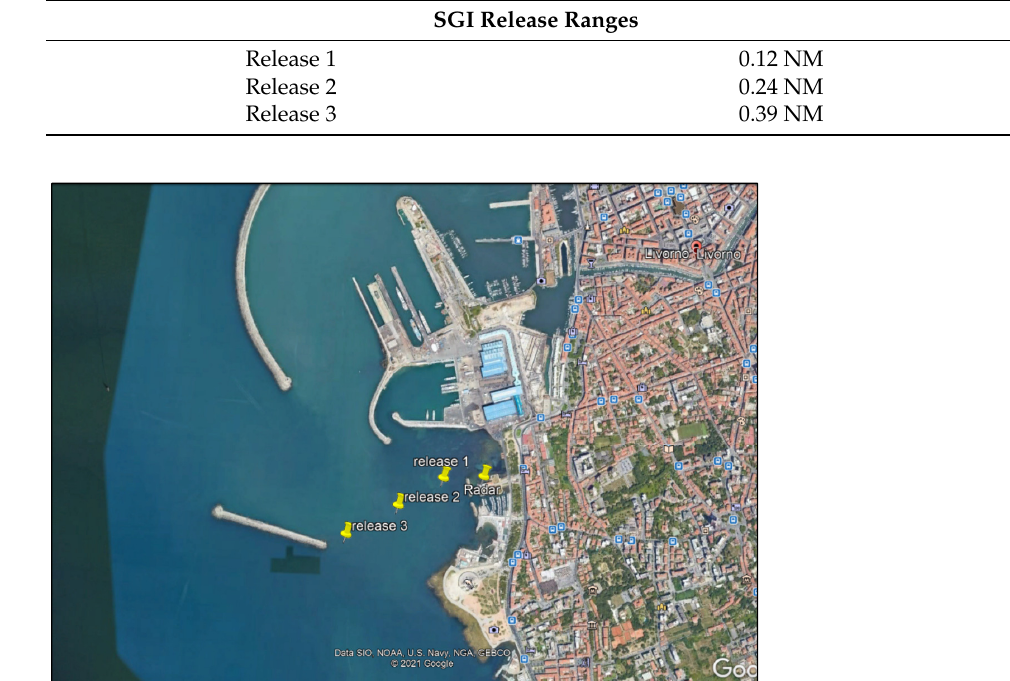
Figure 6. Map with the locations of the releases of the SGI modules (Google, images © 2019 CNES). Table 3. Release ranges of the SGI modules.